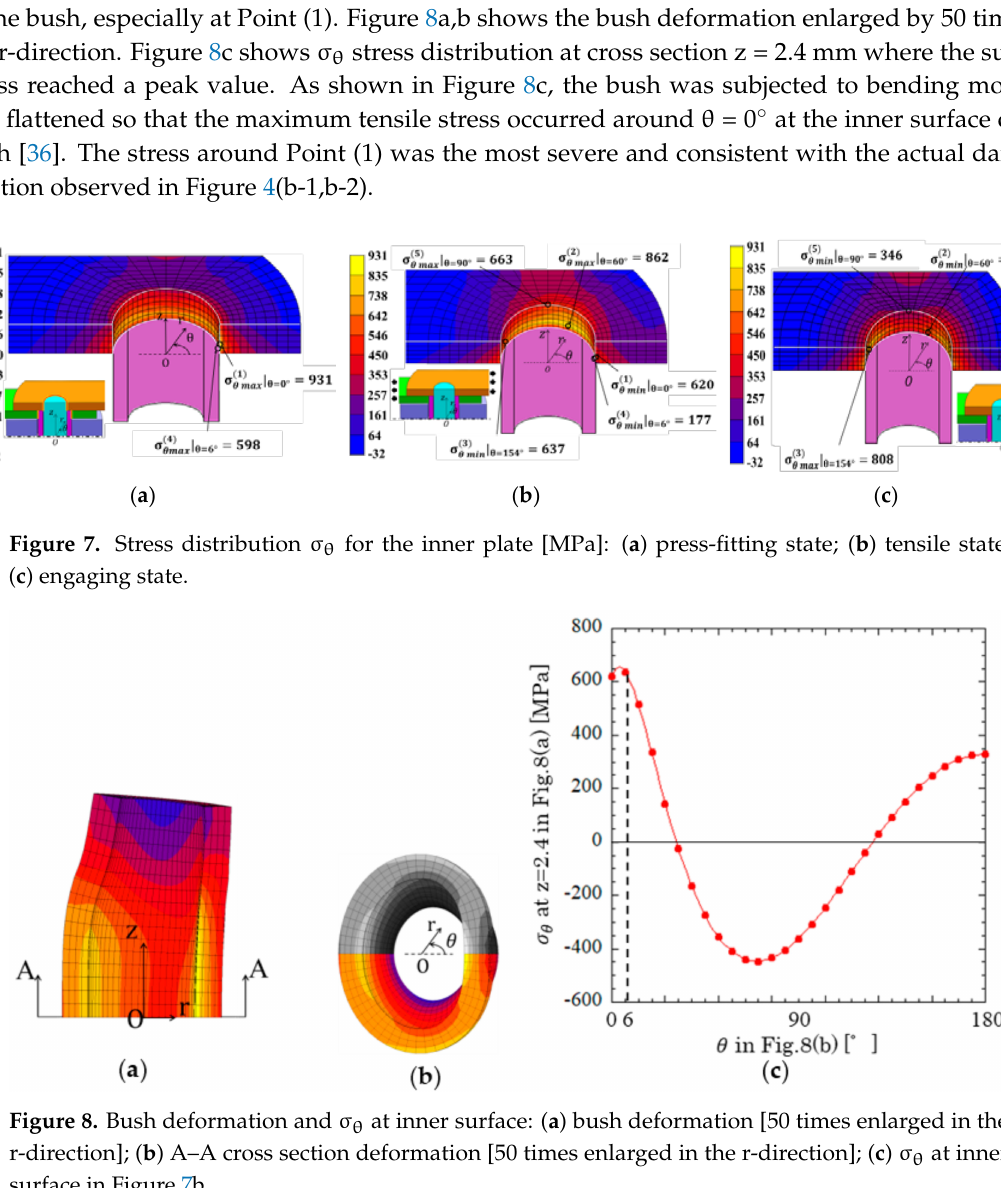
Figure 9. Fatigue limit diagram for inner plate [MPa]. 4.3. Stress Analysis Result for Outer Plate Figure 10 shows the results for the outer plate under (a) press-fitting state, (b) tensile state, and (c) engaging state. Similar to the inner plate, the tensile stress near the hole of the outer plate was very high.